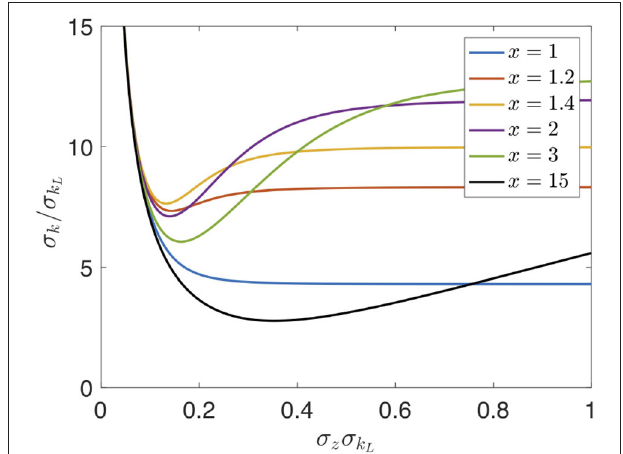
FIGURE 10 | Scaled bandwidth vs. electron beam length for different values of a fixed-badwidth laser stretched with a linear chirp at m